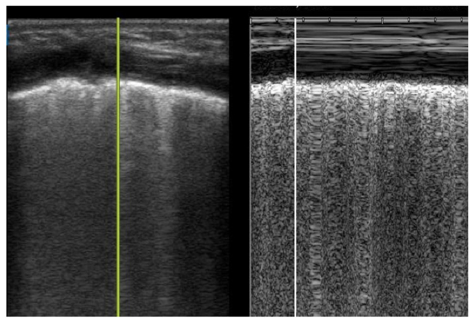
Figure 3. Lung sliding in M-mode. Very low birthweight infant with respiratory distress syndrome with normal lung sliding (seashore sign).